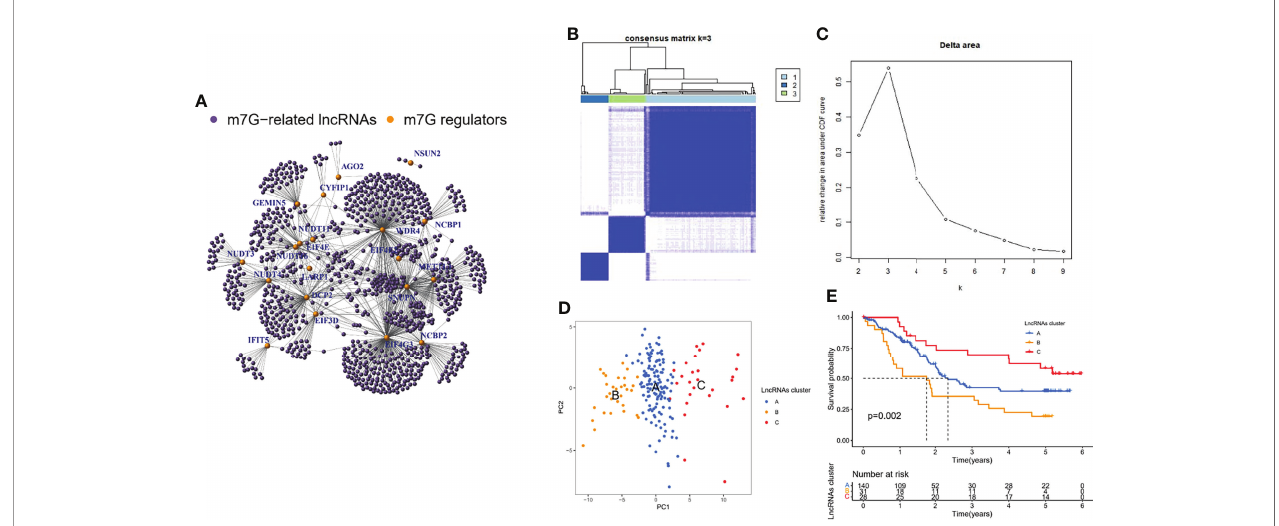
FIGURE 2 | Identi fi cation of m7G-related lncRNAs and their molecular clusters. (A) Co-expression relationship between m7G-related lncRNAs and m7G regulators. (B) Consensus clustering matrix for k = 3. (C) Relative change in area under the CDF curve for k = 2 through 9. (D) PCA showed that the clusters determined based on the expression of m7G-associated lncRNAs well distinguish ESCC into three clusters. (E) Kaplan-Meier curves of OS for three clusters in